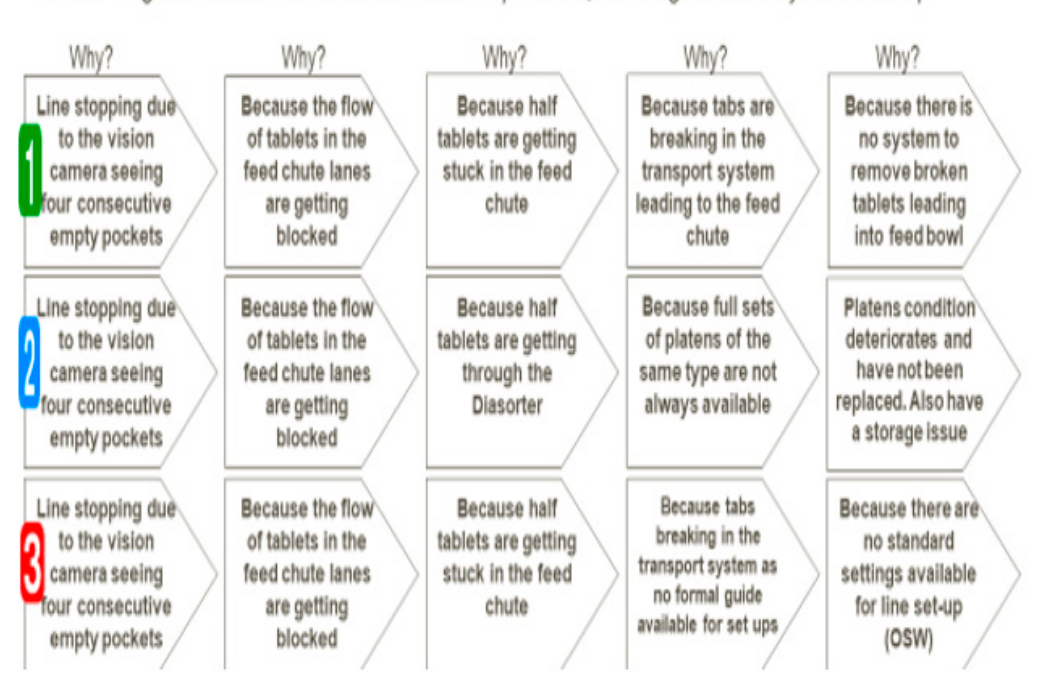
Figure 17. Five Whys analysis being conducted on the tablet feed issue led to root cause and corrective actions which addressed the reason for feed issues and tables getting broken or stuck.